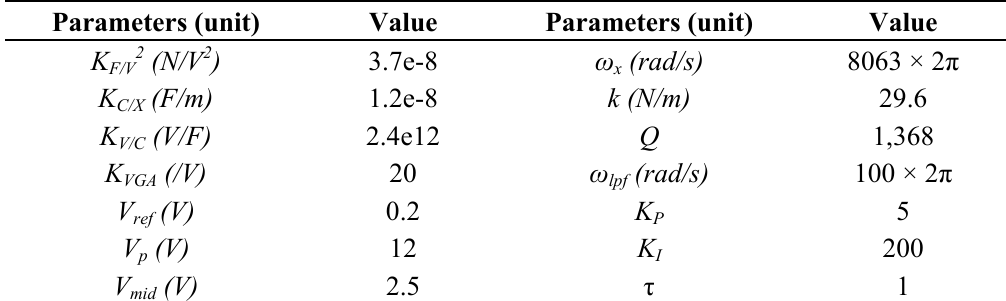
Table 2. Parameters of the control loop simulated in